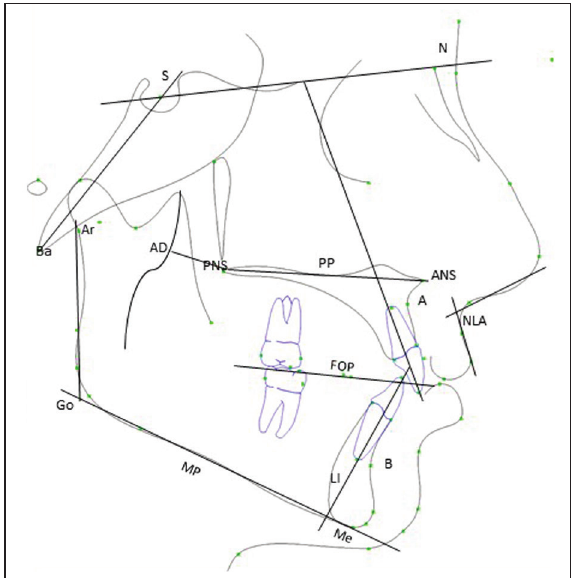
Figure 3. Lateral cephalometric reference landmarks, planes and angles analysed at pretreatment (T1) and post-treatment